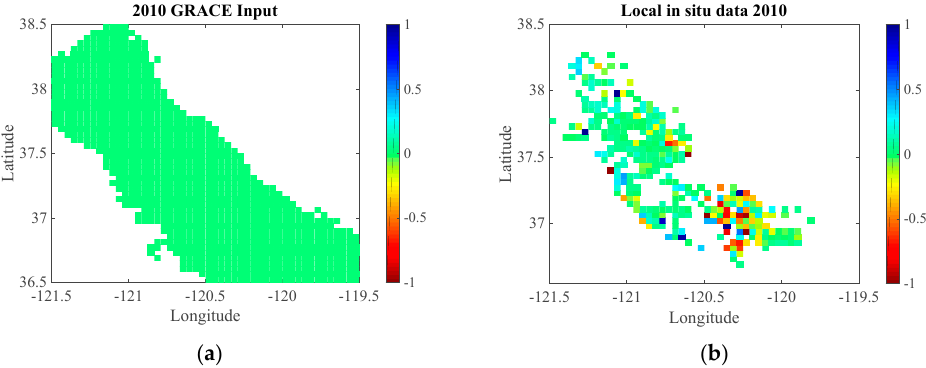
Figure 5. ( a ) Spatial resolution of available remote sensing water storage change data over study region for 2010 (m); ( b ) Spatial resolution of in situ water storage change data over study region for 2010 (m).